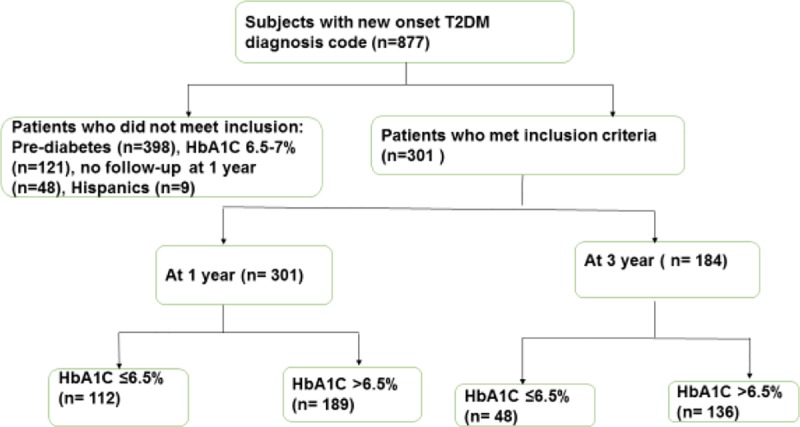
STROBE flowchart.A total of 301 patients met the inclusion criteria.